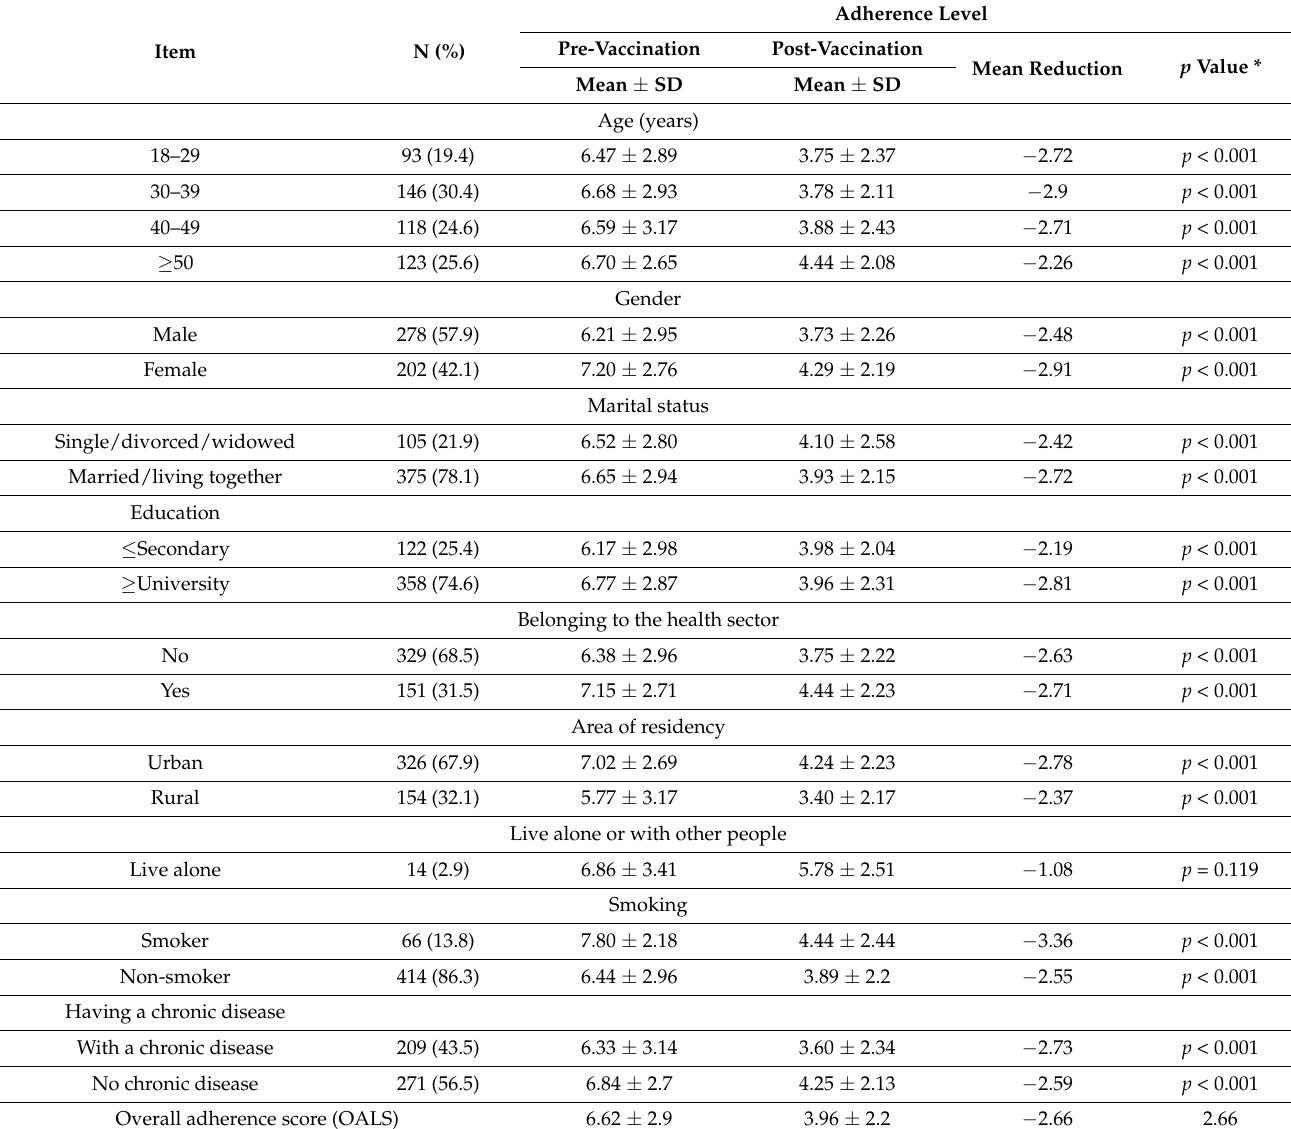
Table 2. Comparison of pre- and post-COVID-19 vaccination levels of adherence to personal protective measures among 480 participants in the Jazan region according to their sociodemographic